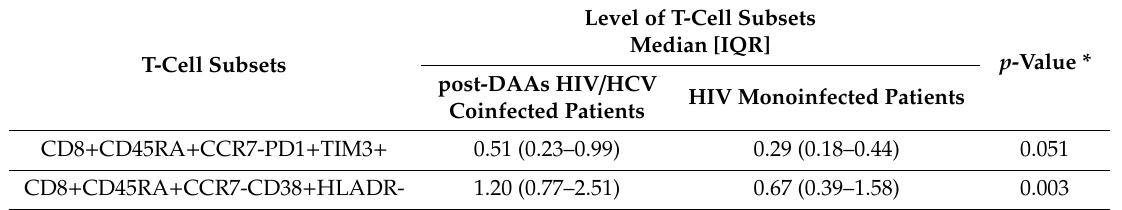
Figure 6. Canonical discriminant analysis comparing the phenotypic profile of T cells between HIV-monoinfected patients (green dots), post-DAAs HIV/HCV coinfected patients (blue dots) and seronegative controls (red dots). Table 3. Levels of different T-cell subsets in HIV/HCV coinfected patients after DAAs treatment (post-DAAs) compared to HIV monoinfected patients.